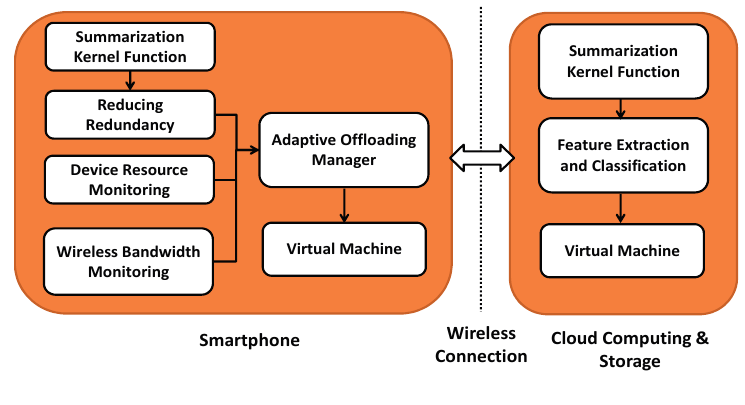
Figure 3. Architecture of the video summarization offloading